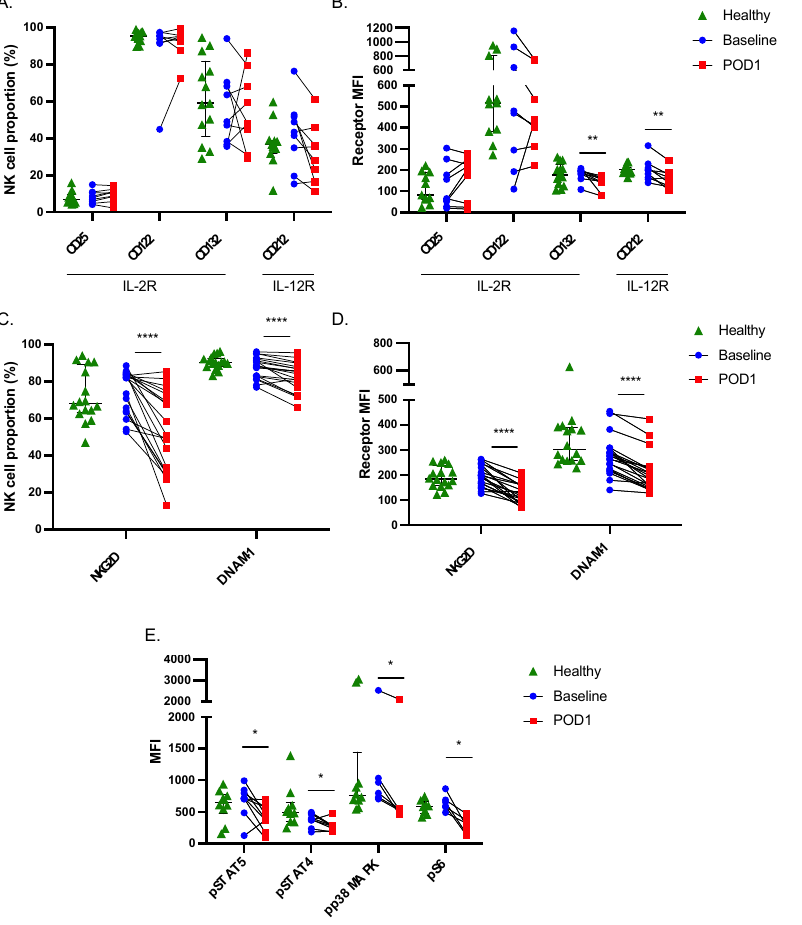
Figure 2. Postoperative NK cells have significantly reduced cytokine and activating receptor expression and reduced phosphorylation of downstream signaling proteins. Whole blood was collected from healthy donors (green, median ± IQR shown) or patients undergoing cancer surgery at baseline (blue) and POD1 (red). Matched baseline and POD1 samples are indicated. Expression (% and MFI) of IL-2R subunit CD132 and IL-12R subunit CD212 (( A ) (%)/( B ) (MFI)) and activating receptors NKG2D and DNAM-1 (( C ) (%)/( D ) (MFI)) is shown. The phosphorylation of all assessed downstream signaling proteins (pSTAT5, pSTAT4, pP38 MAPK, pS6) in response to stimulation with rIL-2/12 was significantly reduced in NK cells on POD1 ( E ). * p ≤ 0.05, ** p ≤ 0.005, **** p ≤ 0.00005.